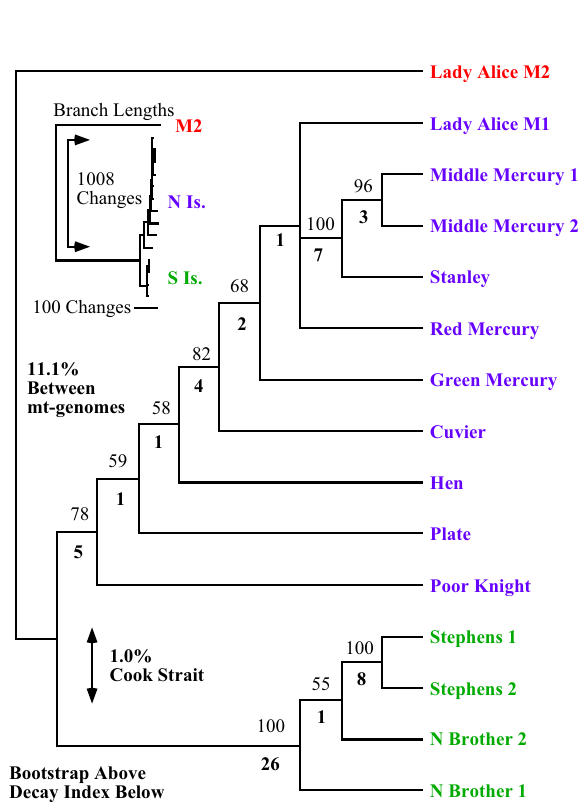
Fig. 3 Phylogenetic relationships of Tuatara populations in relation to Lady Alice Island molecules (M1 and M2). Analysis of 12 mt-protein- coding genes from published data 9,10 not including ND5 in relation to both M1 and M2 sequences from LAI reported here. Bootstraps are depicted above with decay indices below. The tree has a length of 1302 steps from analysis of 9522 aligned sites of which 170 are parsimony informative; the entire tree collapses in 26 steps, hence the decay index below branches. Using LAI M2 as a root, it is implicated it is placed between northern and southern populations forming two groups separating in the Cook Strait. These northern and southern groups have only 1.0% sequence divergence between them, while sequence divergence to LAI M2 is 11.1%. The upper left corner shows relative branch lengths with the LAI M2 sample considerably different in nucleotide changes. Phylogram depiction of the shortest tree illustrates branch length DNA changes along the shortest